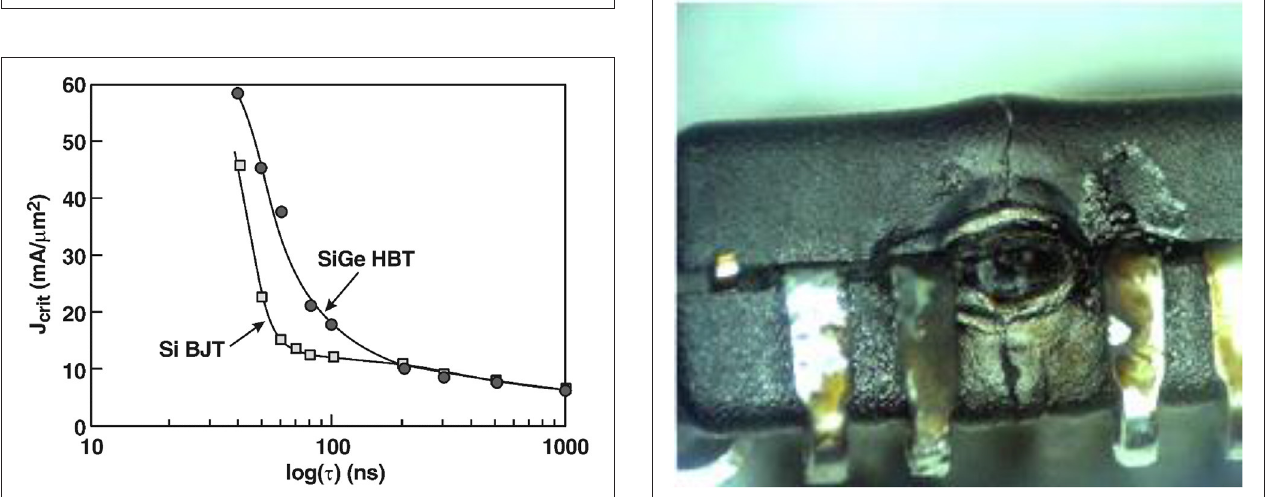
FIGURE 17 | EOS packaging failure (with permission from John Wiley and Sons